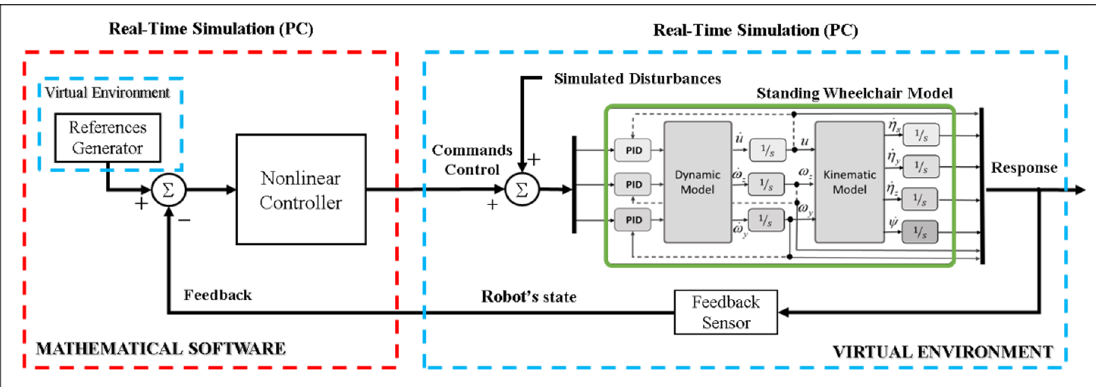
Figure 1. Block diagram for the FS technique.